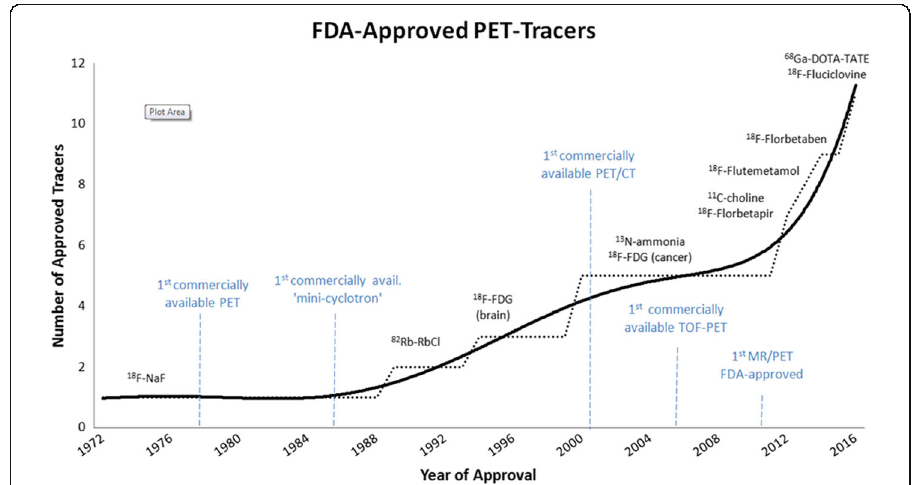
Fig. 1 Timeline of Food and Drug Administration (FDA)-approvals of PET tracers and technical milestones, from 1972 to 2016. Abbreviations: NaF: Sodium fluoride, RbCl: Rubidium chloride, FDG: Fluorodeoxyglucose, PET: Positron Emission Tomography, CT: Computed Tomography, MRI: Magnetic Resonance Imaging, TOF: